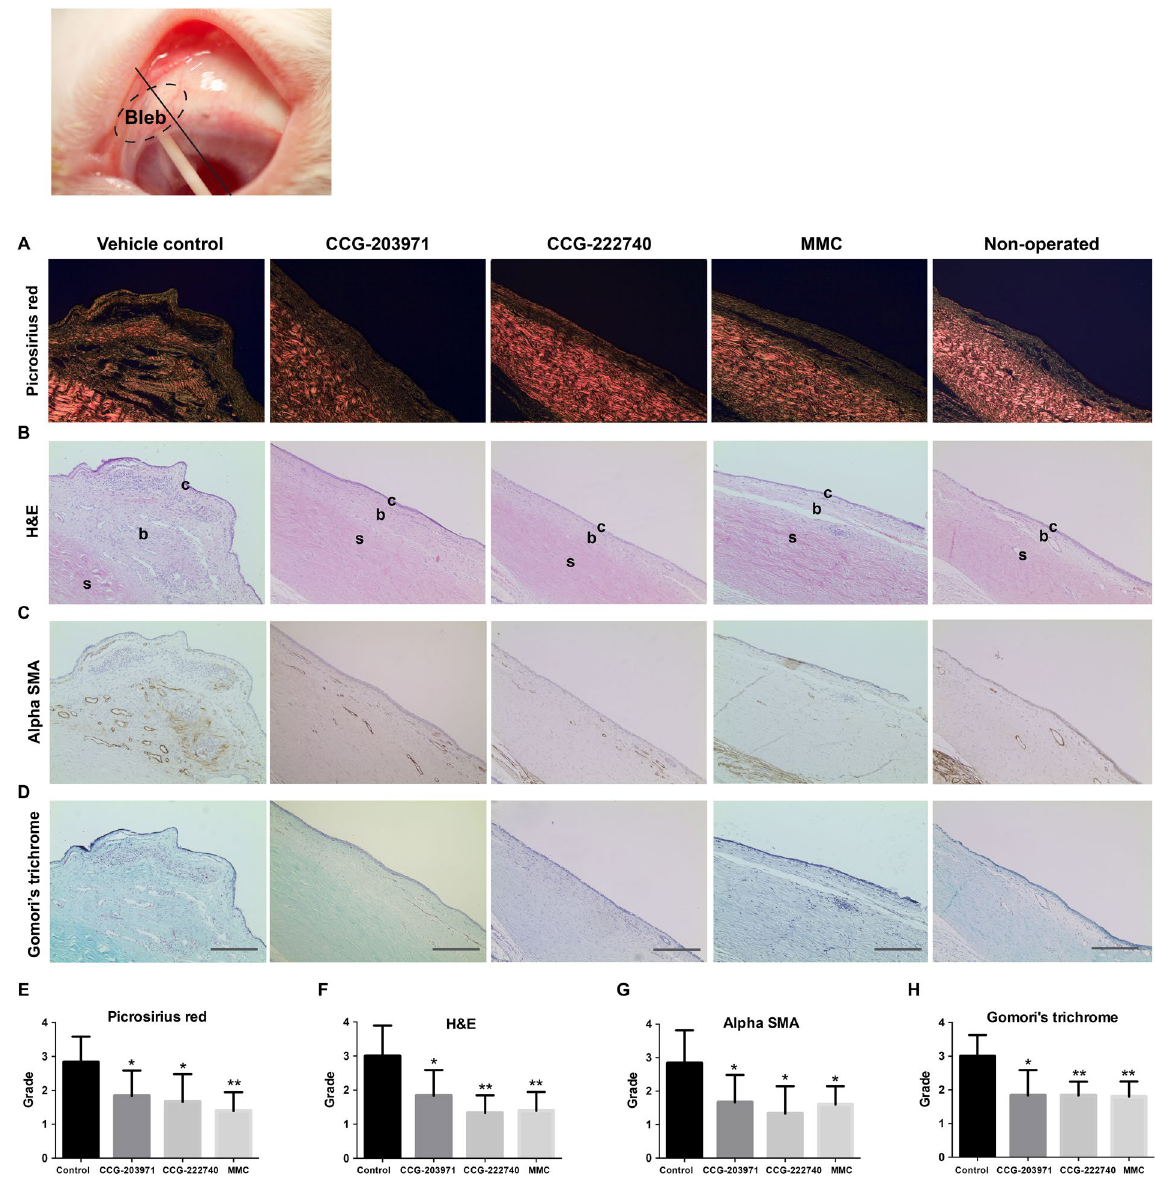
Figure 5. Local delivery of CCG-222740 or CCG-203971 prevents scar tissue formation. The white filtration tube was used as landmark, and tissue was sectioned through the bleb area on a plane 2 mm from the tube and stained (black line). The left operated eyes were compared to the right non-operated eyes, which were used as controls for the appearance of normal conjunctival tissue. Scale bar = 100 μ m; c, conjunctiva, b, subconjunctival space, s, sclera. Analysis was performed using the mean results in each treatment group. Statistically significant differences are expressed as * P < 0.05; ** P < 0.01. ( A , E ) Picrosirius red; ( B , F ) H&E; ( C , G ) α SMA; ( D , H ) Gomori’s trichrome stain for extracellular matrix and